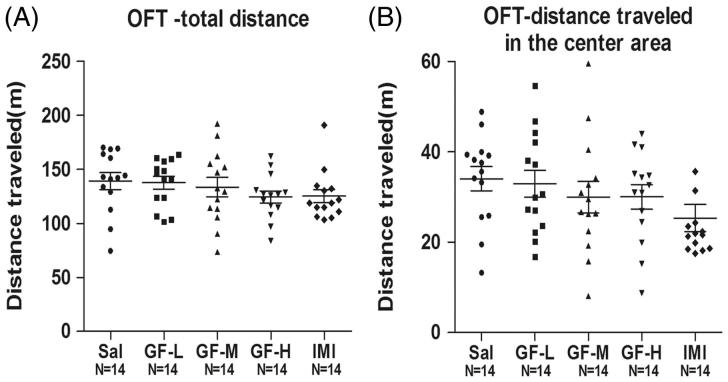
Open field test (OFT) after 3 days of treatment with Griflola frondosa (GF). CD-1 mice were fed with their regular mouse chow, a low dose of Griflola frondosa (GF powder:mouse chow =1:4, GF-L); a medium dose of Griflola frondosa (GF powder:mouse chow =1:2, GF-M); or a high dose of Griflola frondosa (GF powder:mouse chow = 1:1, GF-H). For the positive control group, mice were i.p. injected with imipramine (15 mg/kg/day, IMI). Mice in the negative control group were i.p injected with saline (Sal). After 3 days of treatment with GF-containing food, mice were subjected to the OFT. Total distance travelled and the distance travelled in the centre area were determined by an automated tracking system. The number of mice per group is indicated in each individual graph. Data were analysed by one-way ANOVA and presented as the mean ± SE. (A) The total distance travelled in the field after GF treatment. (B) The distance travelled in the centre area of field after GF treatment.